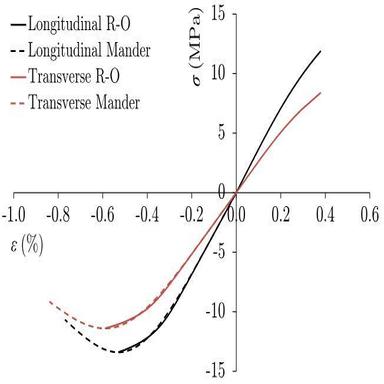
The Ramberg–Osgood (R–O) and Mander models using the average measured material properties of OSB, with positive values of stress and strain signifying tension (where only the R–O model is used) and negative values signifying compression (where both the R–O and Mander models are shown).